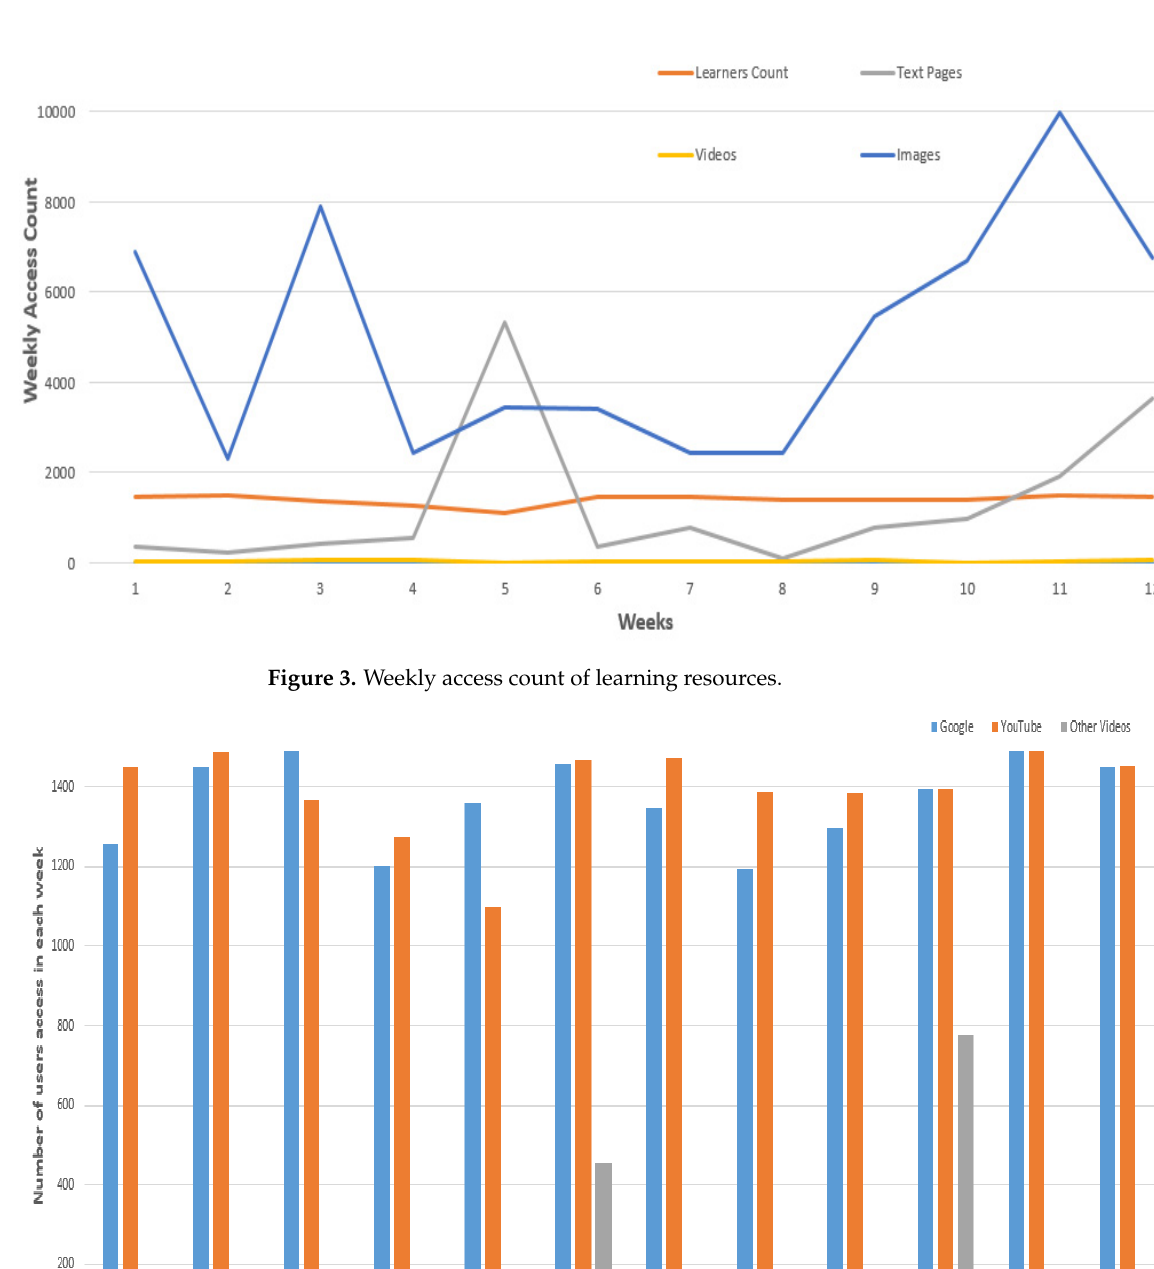
Figure 5. Accessing hours each week for the learning resources. The participants are instructed to write a detailed report about the learning topics before and after completing the learning phase. The detailed report of the learning topics